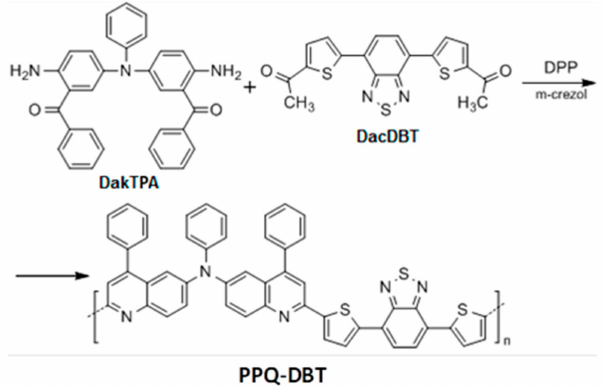
Figure 1. The synthesis of